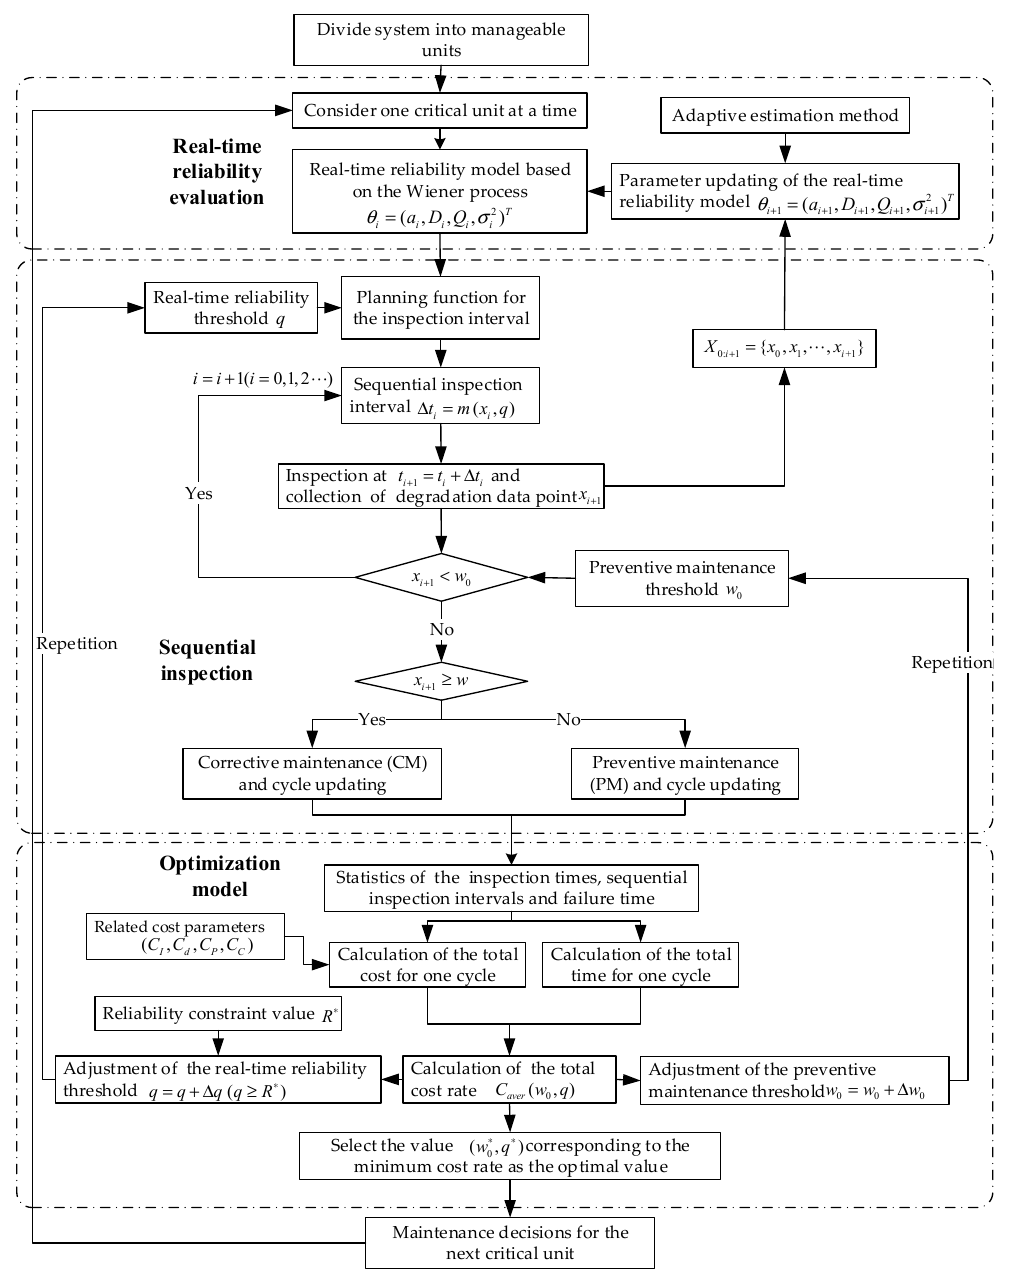
Figure 1. Flow chart of the process of sequential inspection and maintenance optimization.